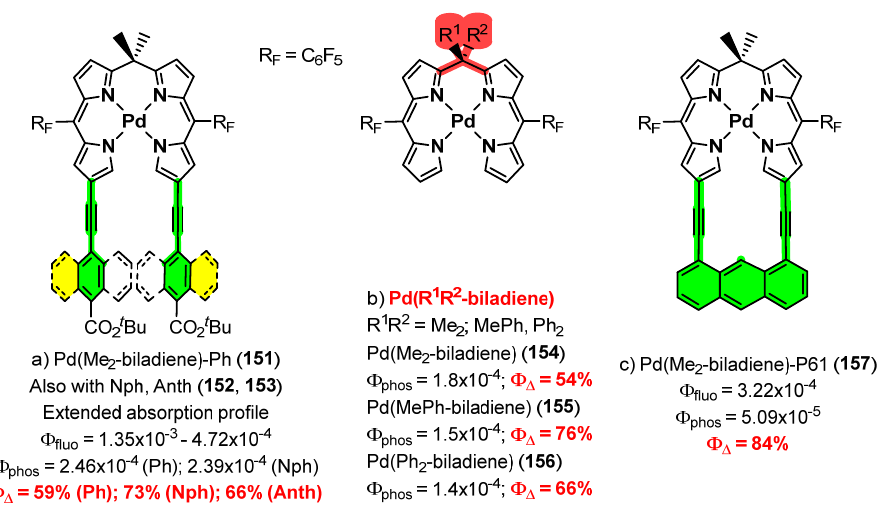
Figure 42. Photophysical properties and quantum yields of 1 O 2 sensitization for biladiene derivatives 151 – 157 . Adapted from [137–139].